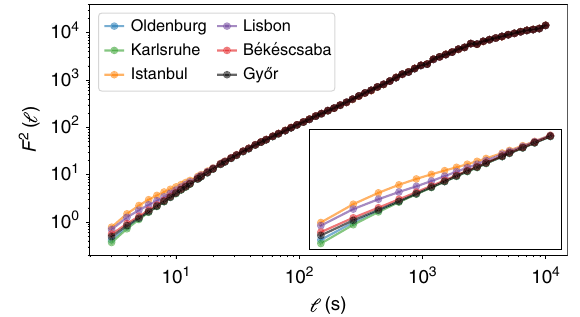
Fig. 7 Detrended Fluctuation Analysis (DFA) connects short and long timescales. We perform a DFA 65 , with order m = 1, in accordance with ref. 64 , and plot the fl uctuation function F 2 ( ℓ ) as a function of the time window length ℓ . The inset magni fi es the values for ℓ ∈ {10 0 … 2 × 10 1 }. The lines connect data points to each other to guide the